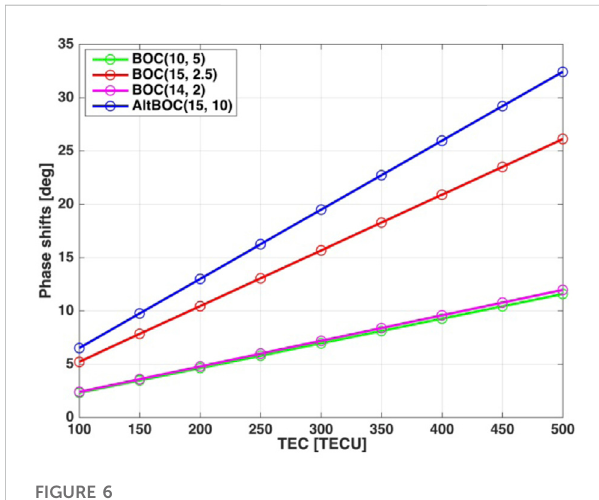
FIGURE 6 Carrier-phase offsets for different TEC values.